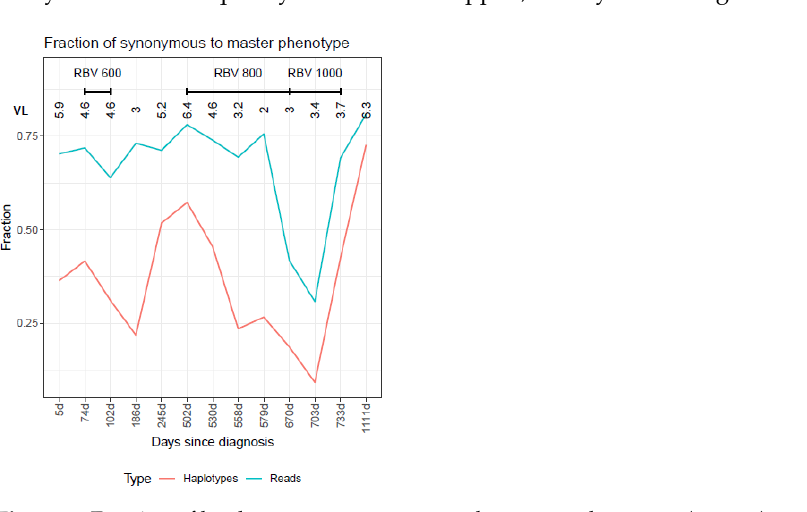
Figure 5. QFF ( A ) and HNP ( B ) plots for the quasispecies as amino acid haplotypes (phenotypes) for the HEV follow-up. Viral loads (VL) are expressed as logarithms. RBV, ribavirin. Pct1 low fitness (0.1 < Freq ≤ 1%), pct0.1 very low fitness (≤0.1%).